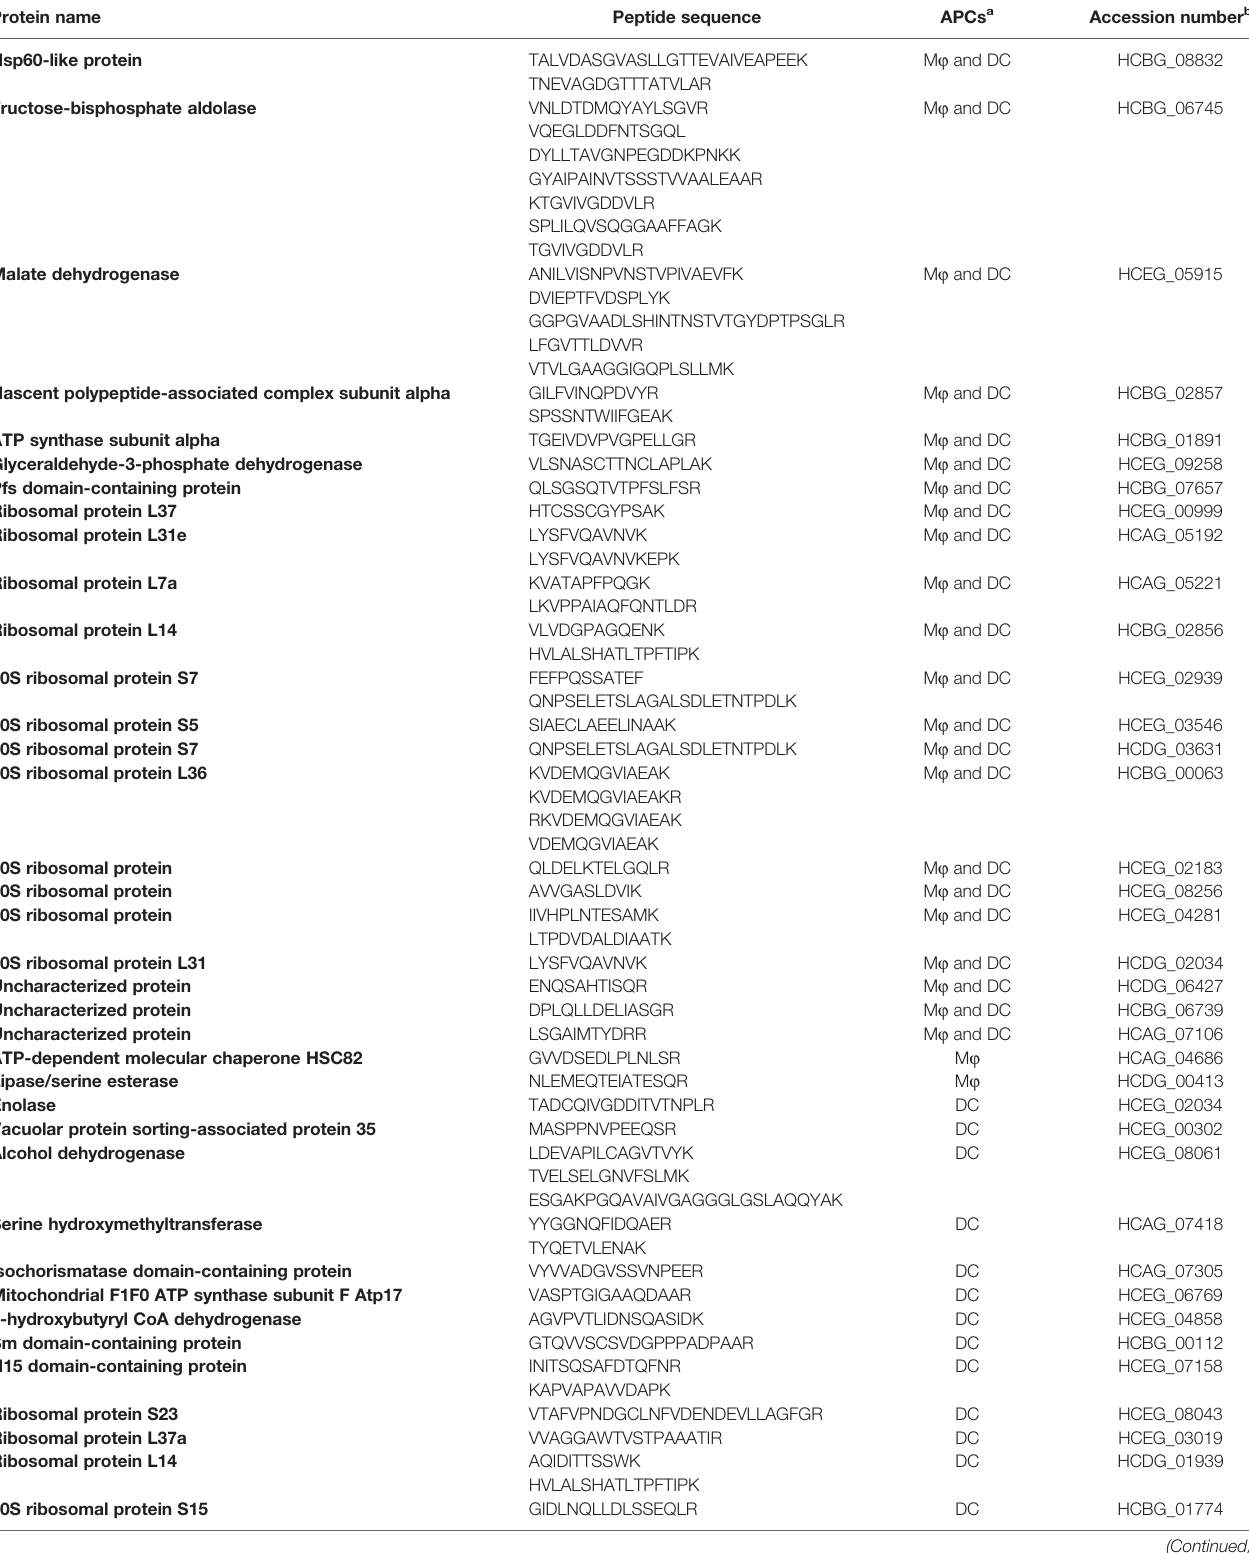
TABLE 2 | MHC-II-binding H. capsulatum peptides from BMDC (DCs) and BMDM (M j ) bone marrow-derived from C57BL/6